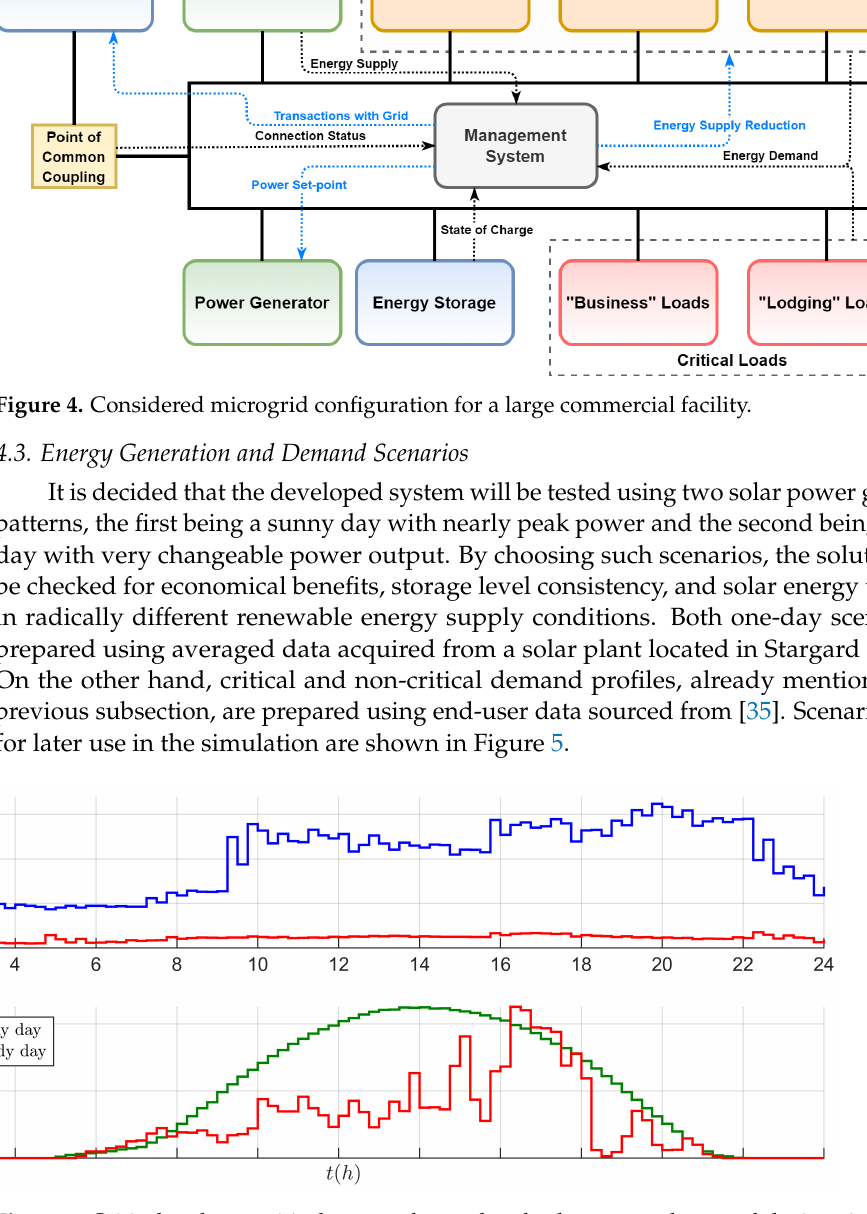
Figure 5. Critical and non-critical energy demand and solar energy data used during